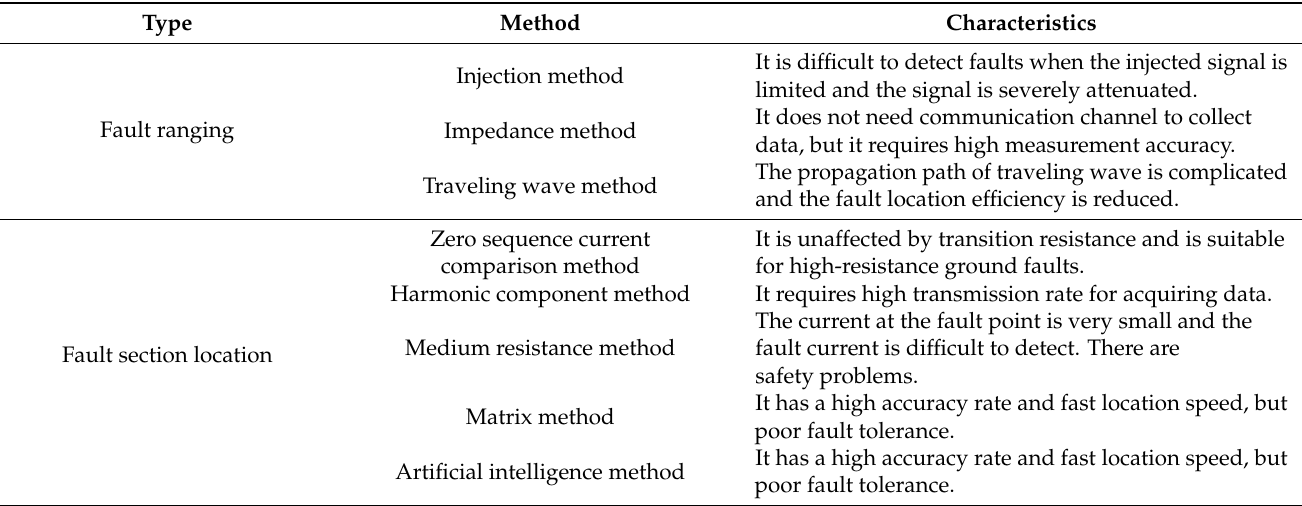
Table 1. Characteristics of various fault location